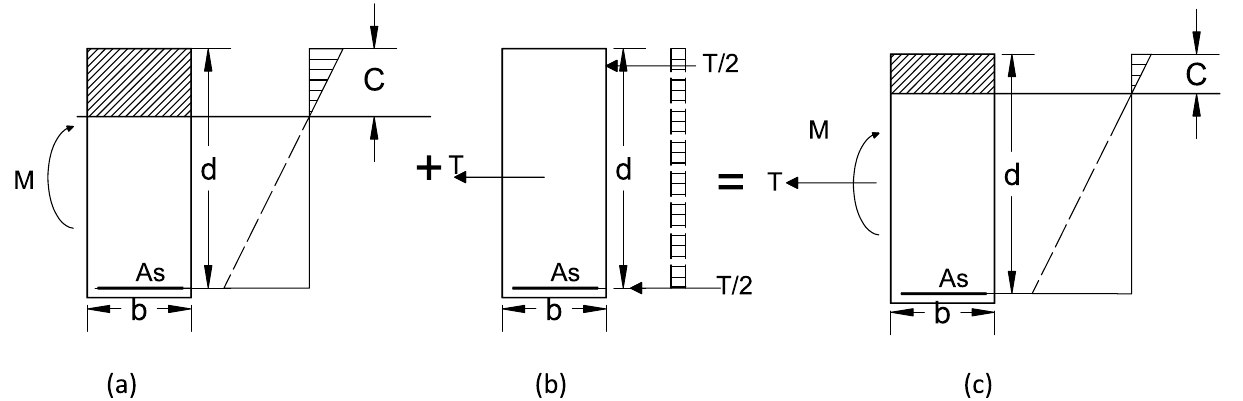
Figure 4. Strain diagram for ( a ) flexure only, ( b ) tension only, and ( c ) flexure and tension.